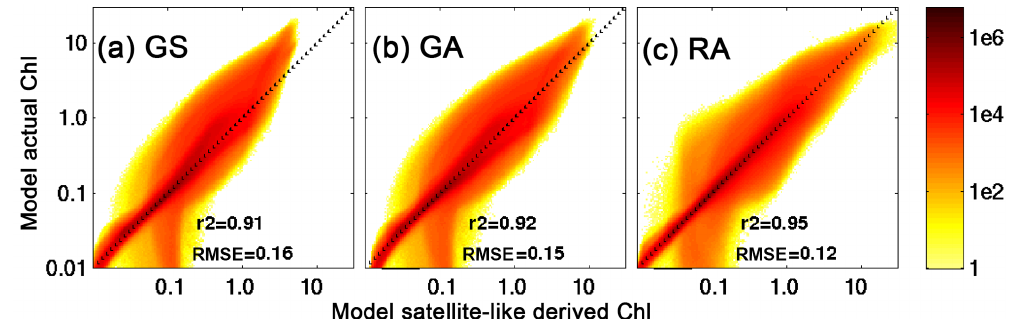
Figure 5. Two-dimensional density histogram of model “actual” and model “derived” Chl a using algorithm coefficients found for: (a) default experiment using approach 1 (global, subsampled output, GS), (b) default experiment using approach 2 (global, all output, GA), (c) default experiment using approach 3 (region-specific, RA). The dashed line indicates the 1-to-1 line. Colour indicates the log of the fraction of all data that occur in phase space (the lightest yellow reflects a single instance in that bin). Statistics noted on the plot are for the log transformed output. The r 2 and RMSE in linear space is provided in Table 2.